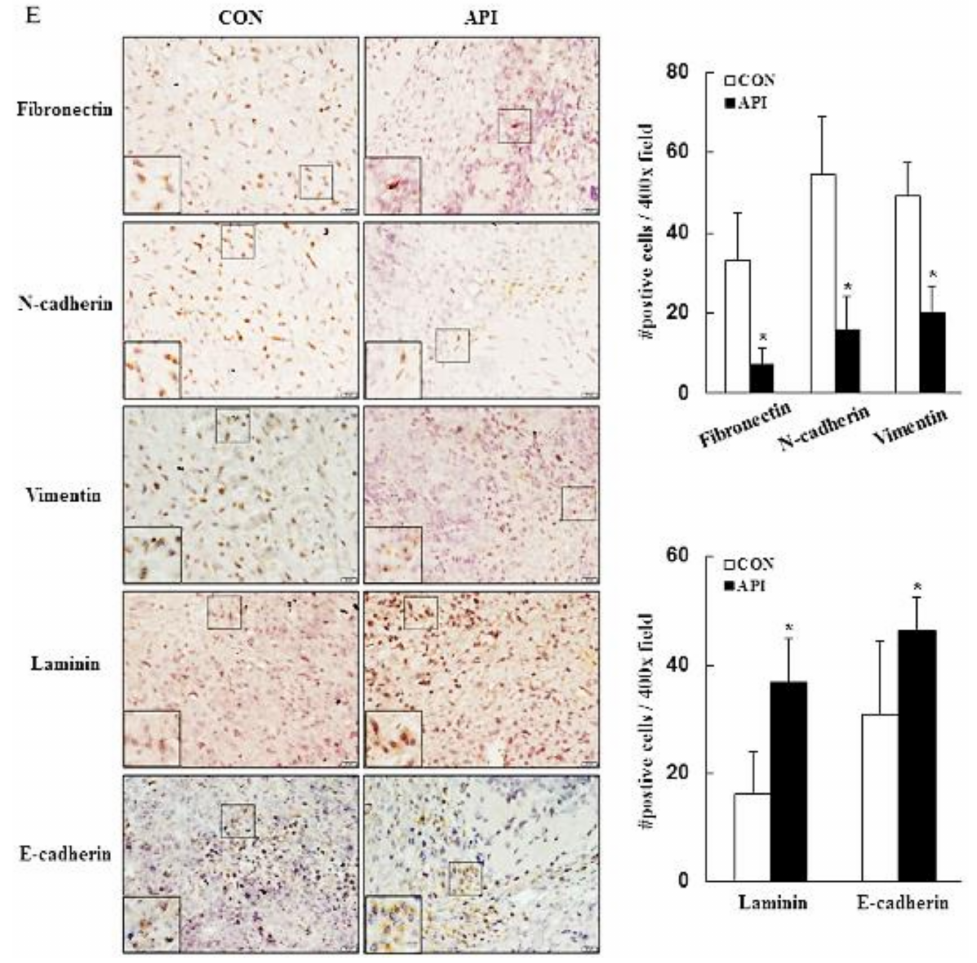
Figure 6. Apigenin suppresses the growth of C33A xenograft tumors in vivo. C33A human cervical cancer cells (1 × 10 7 cells) were implanted into the right flank of BALB/c nude mice. When the subcutaneous tumor volume reached ~200 mm 3 , mice were treated with the solvent control (10% DMSO) or apigenin (IP, 50 mg/kg/day) for 16 days. ( A ) Schematic representation of the experiment. ( B ) Representative image of a tumor, and average tumor volume and body weight. Tumor tissue samples were analyzed by hematoxylin, eosin staining ( C ), and immunohistochemistry ( D , E ) to examine the histopathology and expression levels of ki67, Bcl-2, cyclin B1, phospho-FAK, paxillin, integrin β 1, fibronectin, N-cadherin, vimentin, laminin, and E-cadherin (shown as brown staining) (H&E, 400 × , bar = 20 µ m; IHC, 400 × , bar = 20 µ m). Values represent the mean ± SD ( n = 6); * p < 0.01, *** p < 0.001 indicate significant differences as compared with the corresponding control. CON, control; API,